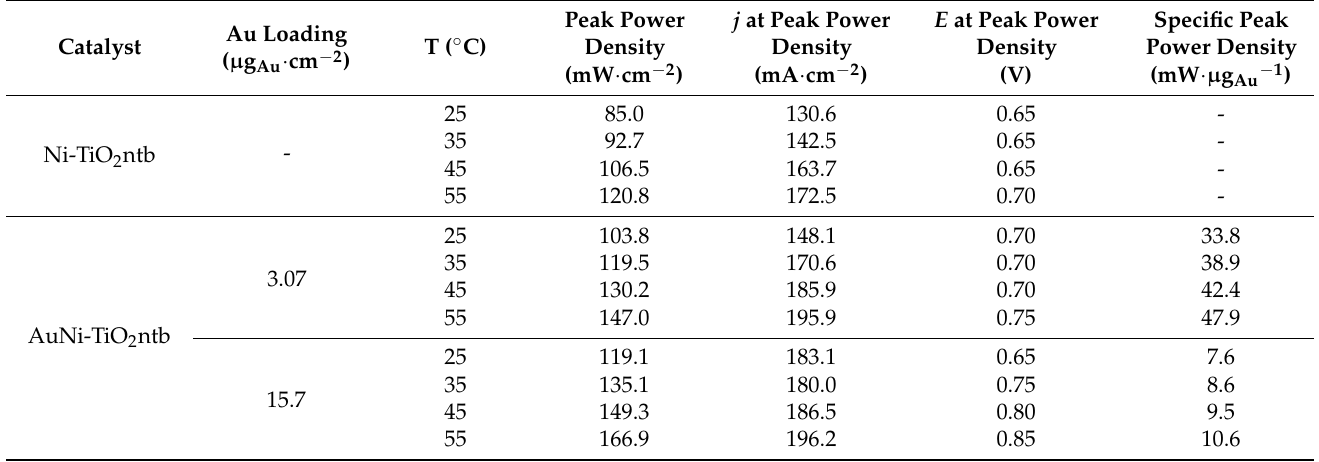
Table 5. Summary of the main cell electrochemical parameters for NaBH 4 -H 2 O 2 fuel cell using Ni-TiO 2 ntb and AuNi-TiO 2 ntb anode catalysts obtained at different